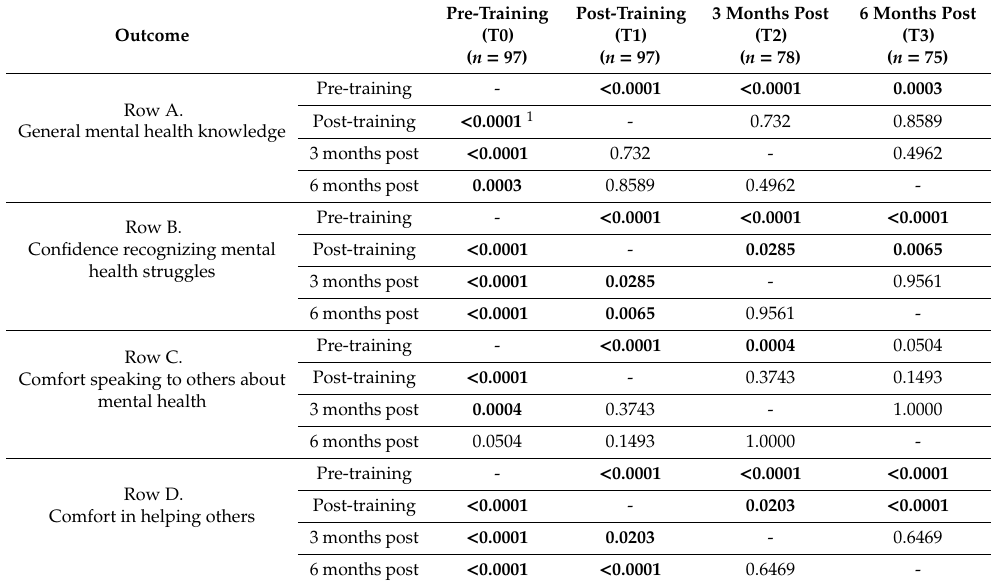
Table 2. Self-reported di ff erences * for agricultural community members in Ontario, Canada in